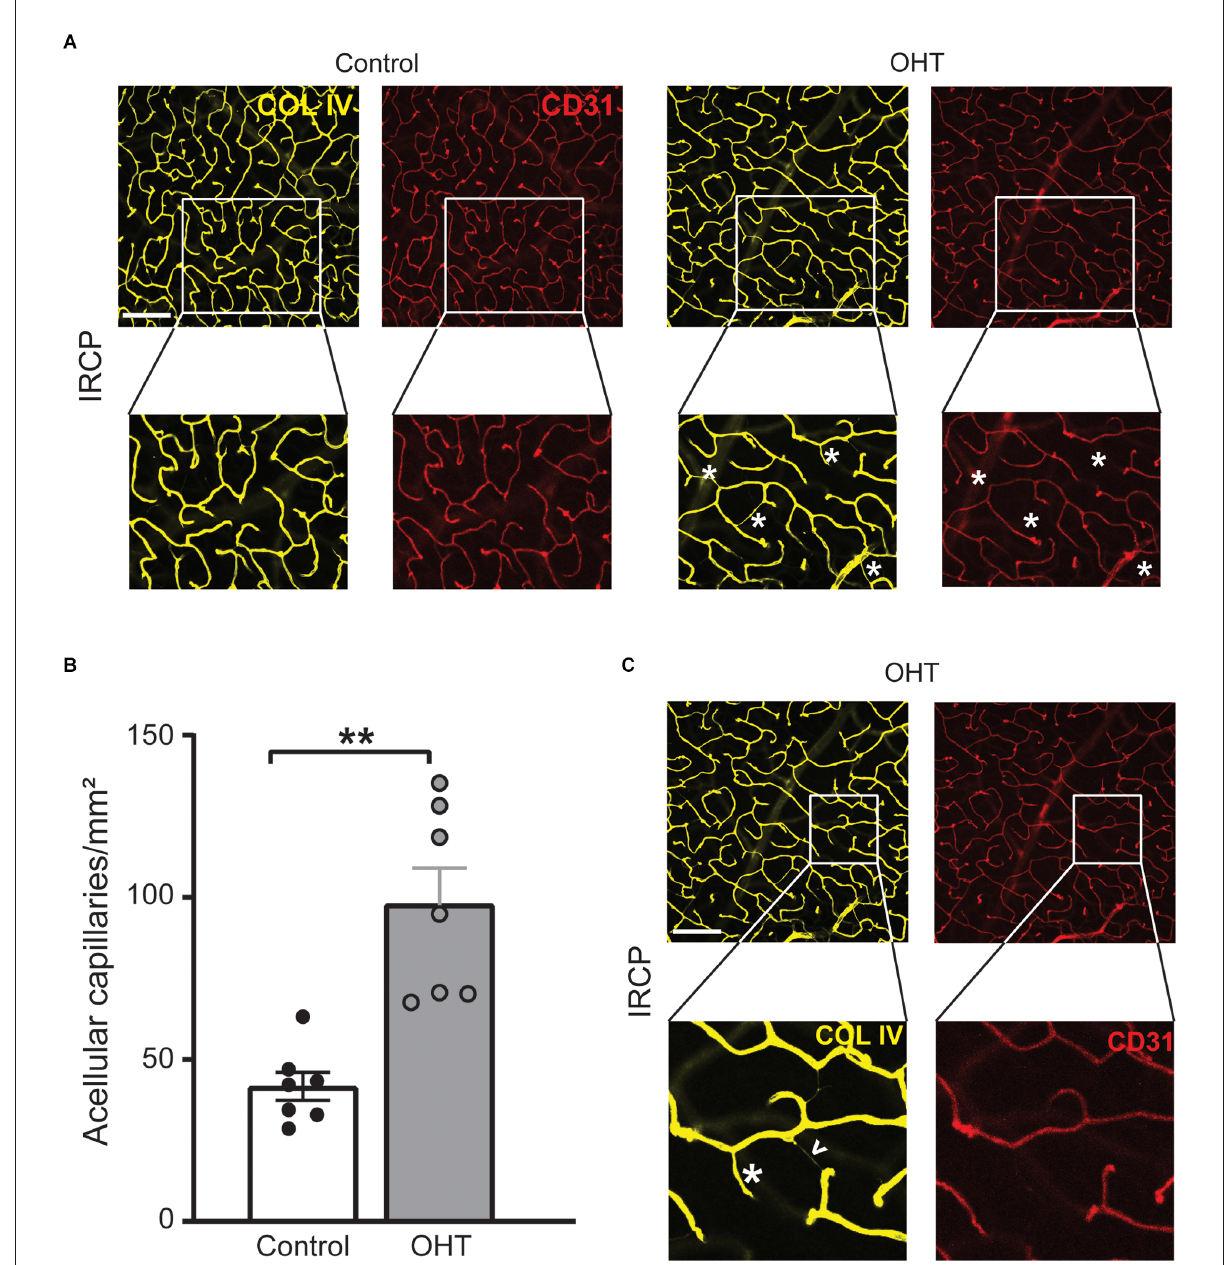
FIGURE5 (A) Representative IRCP images for Collagen IV and CD31 immunostained retinas (top; scale bar = 200 µ m) with zoom for additional detail (bottom). Magnified images show examples of acellular capillaries (ghost vessels) marked with white asterisks. (B) Acellular capillary density (acellular capillaries/mm 2 ) was greatly increased in the IRCP for OHT retinas (paired t -test; ** p < 0.01). (C) Different magnified region of the same representative images ( A , top) highlights the difference between acellular capillaries (white asterisks) and inter-pericyte tunneling nanotubes (IP-TNTs; white